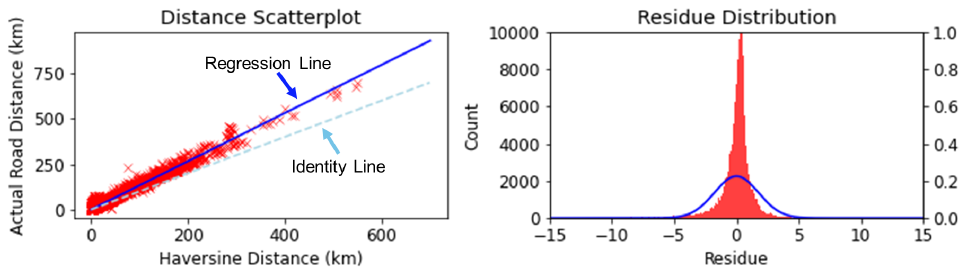
Figure 4. Relationship between the Haversine distance and the actual road distance (in km). Algorithm 1 summarizes the procedure for identification of potential inefficiencies.